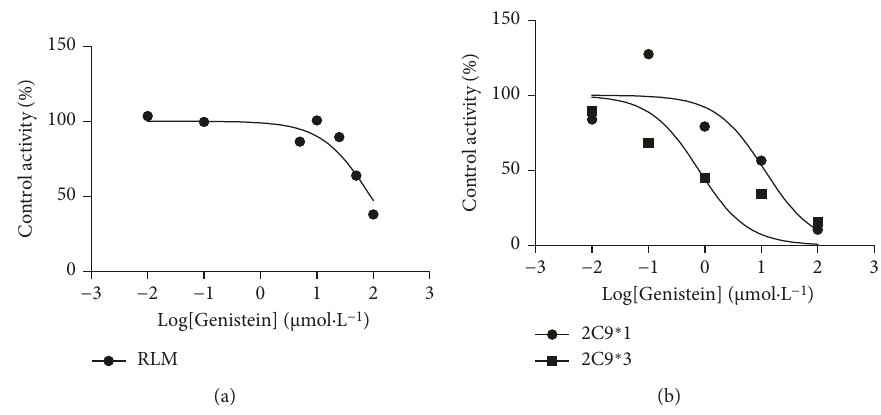
Figure 4: IC50 of genistein on celecoxib in 2C9 ∗ 1, 2C9 ∗ 3, and